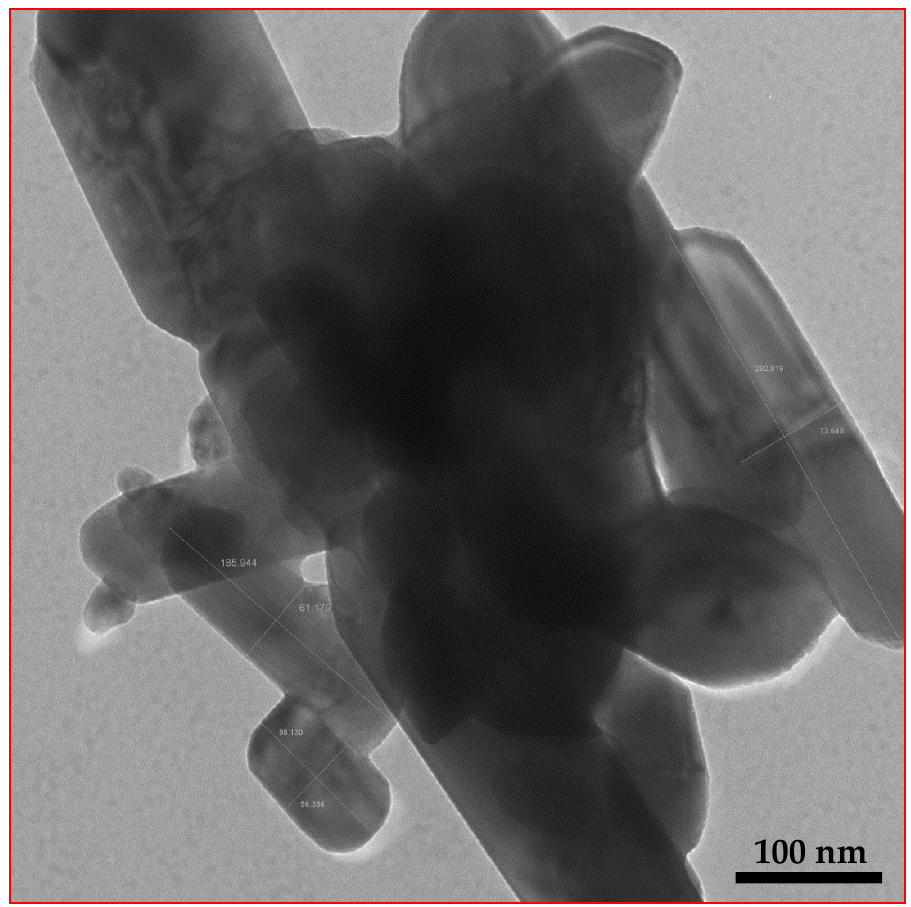
Figure 3. TEM images of Cu-ZnBO-Cp-CT.